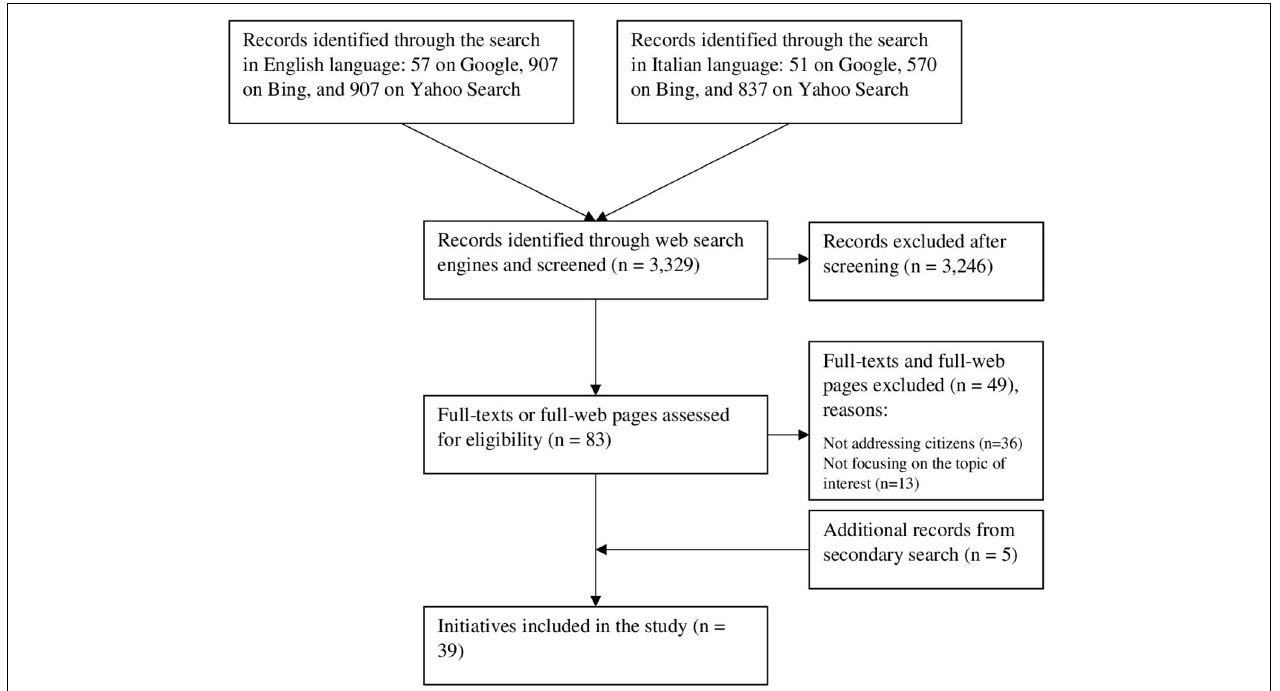
FIGURE 1 | Flowchart of the selection